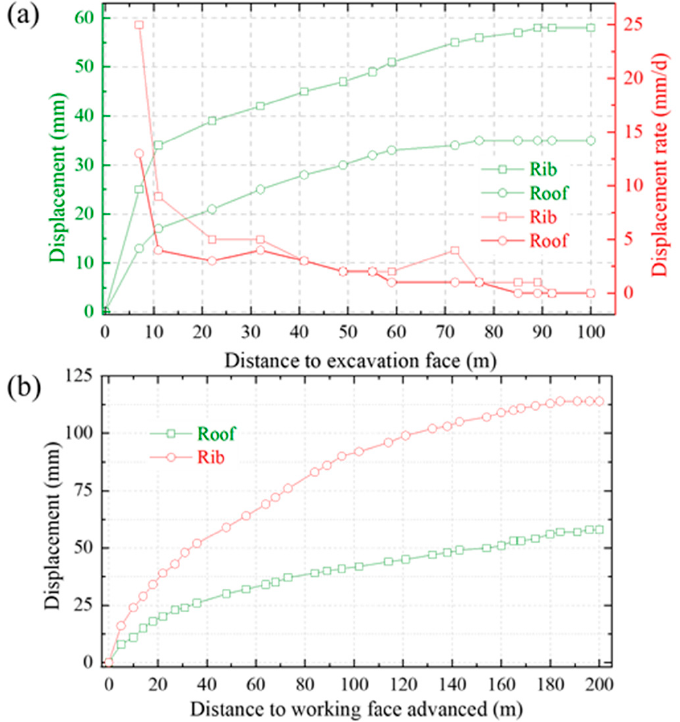
Figure 8. Schematic diagram of borehole location of deep-hole pre-splitting blasting.